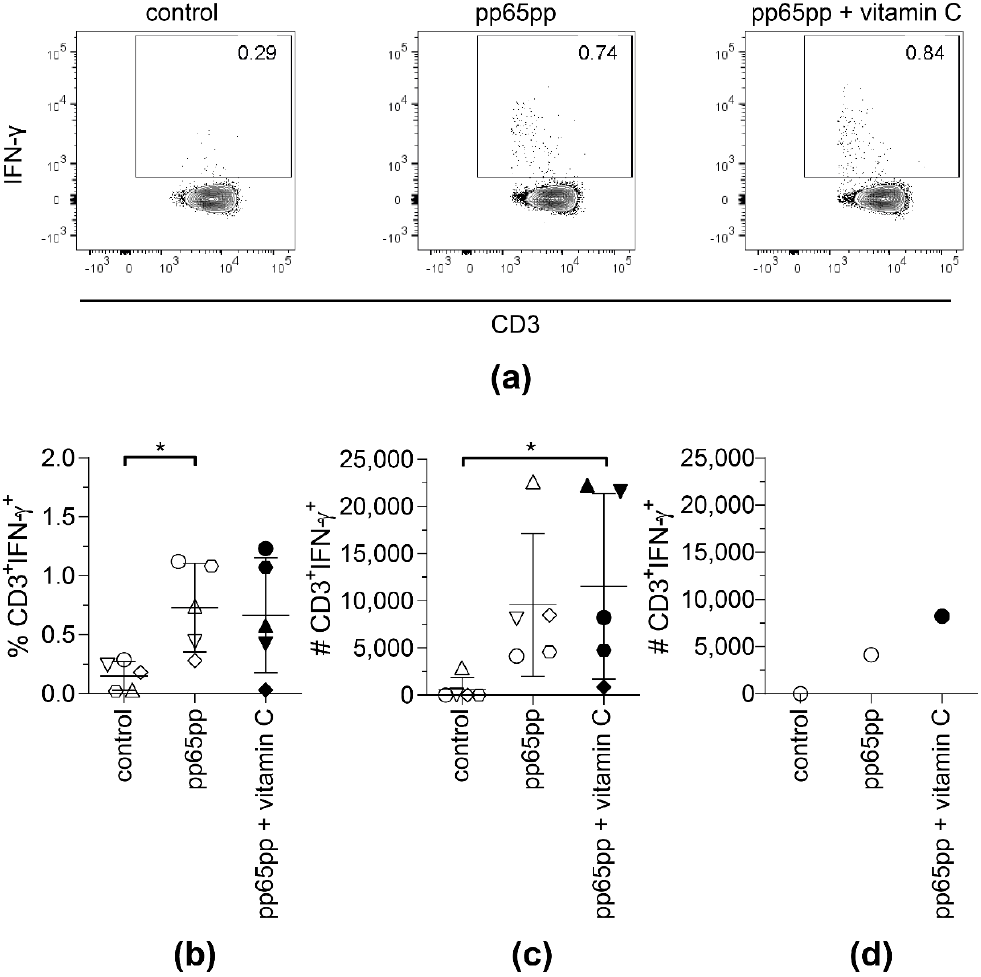
Figure 3. The yield of CMV-specific T cells using CSA is slightly increased upon supplementation with vitamin C. CSA was performed using pp65pp and the magnetically enriched cells were analyzed by flow cytometry. Cells are gated on viable CD3 + lymphocytes based on CD45 expression, scatter properties (SSC-A), 7-AAD staining and CD3 expression. Number of IFN- γ -expressing T cells after enrichment, without (control), with pp65pp (pp65pp), or with pp65pp and vitamin C supplementation (pp65pp + vitamin C) during CSA shown as ( a ) representative plots, ( b ) frequency of CD3 + IFN- γ